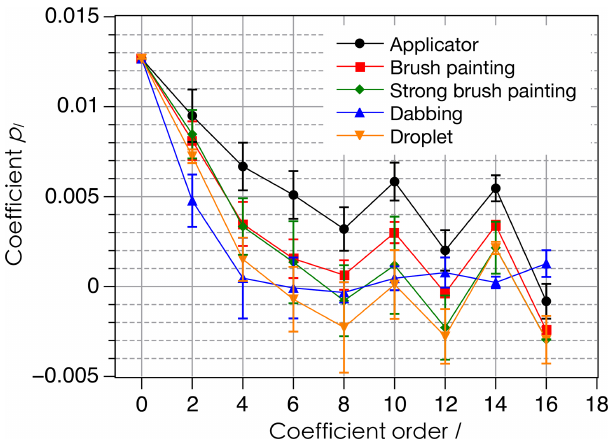
Figure 10. Coefficients p l in the expansion of P ( β ) according to Eq. (6) for the various deposition modes of films. The continuous lines are only guides for the eye, and odd-order coefficients are all zero.